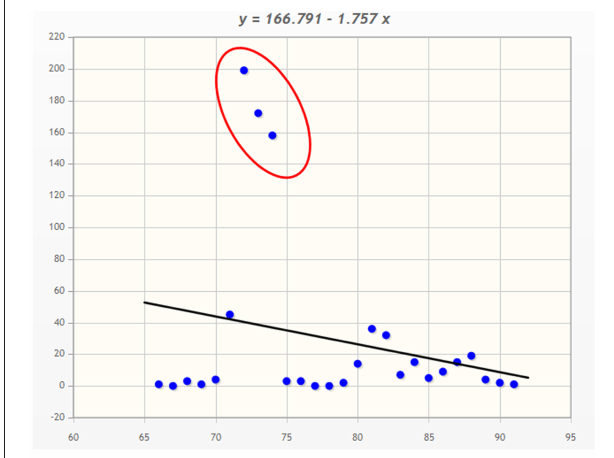
FIGURE 1 | Correlation-regression analysis of number of nucleotides vs. total number of tRNAs in O. sativa . Analysis shows, majority of tRNA contains 70–75